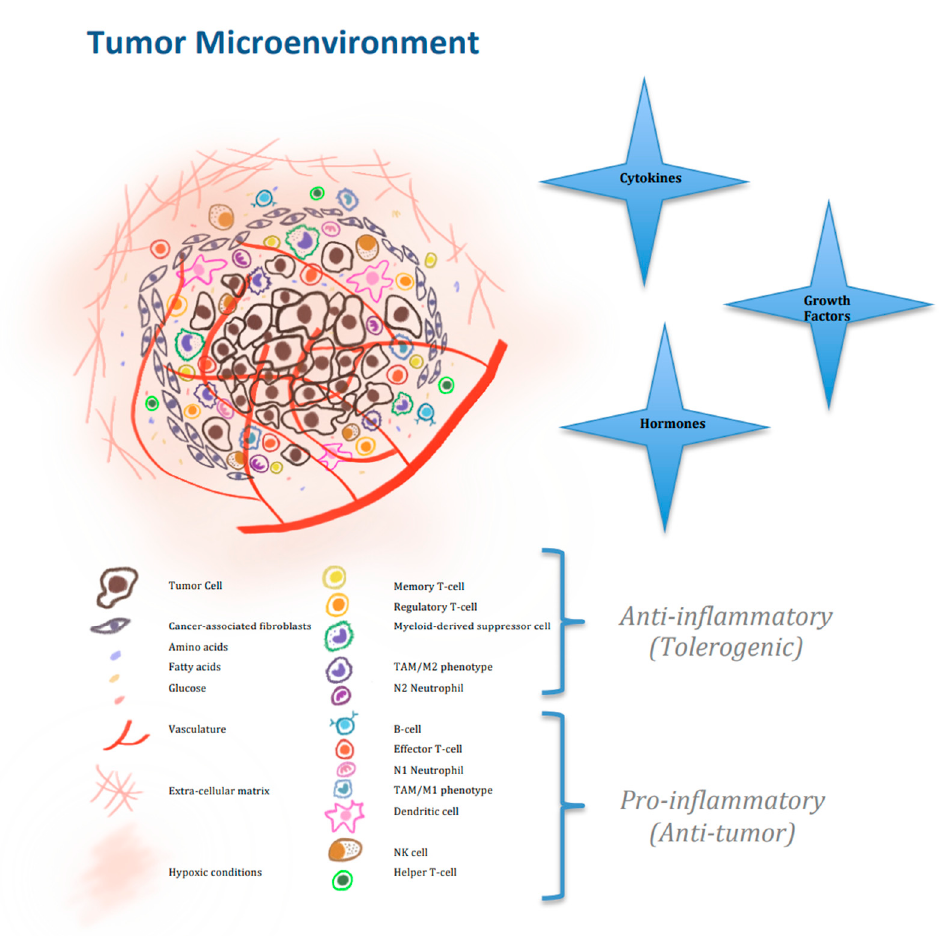
Figure 1. Multiple constituents of the tumor microenvironment.